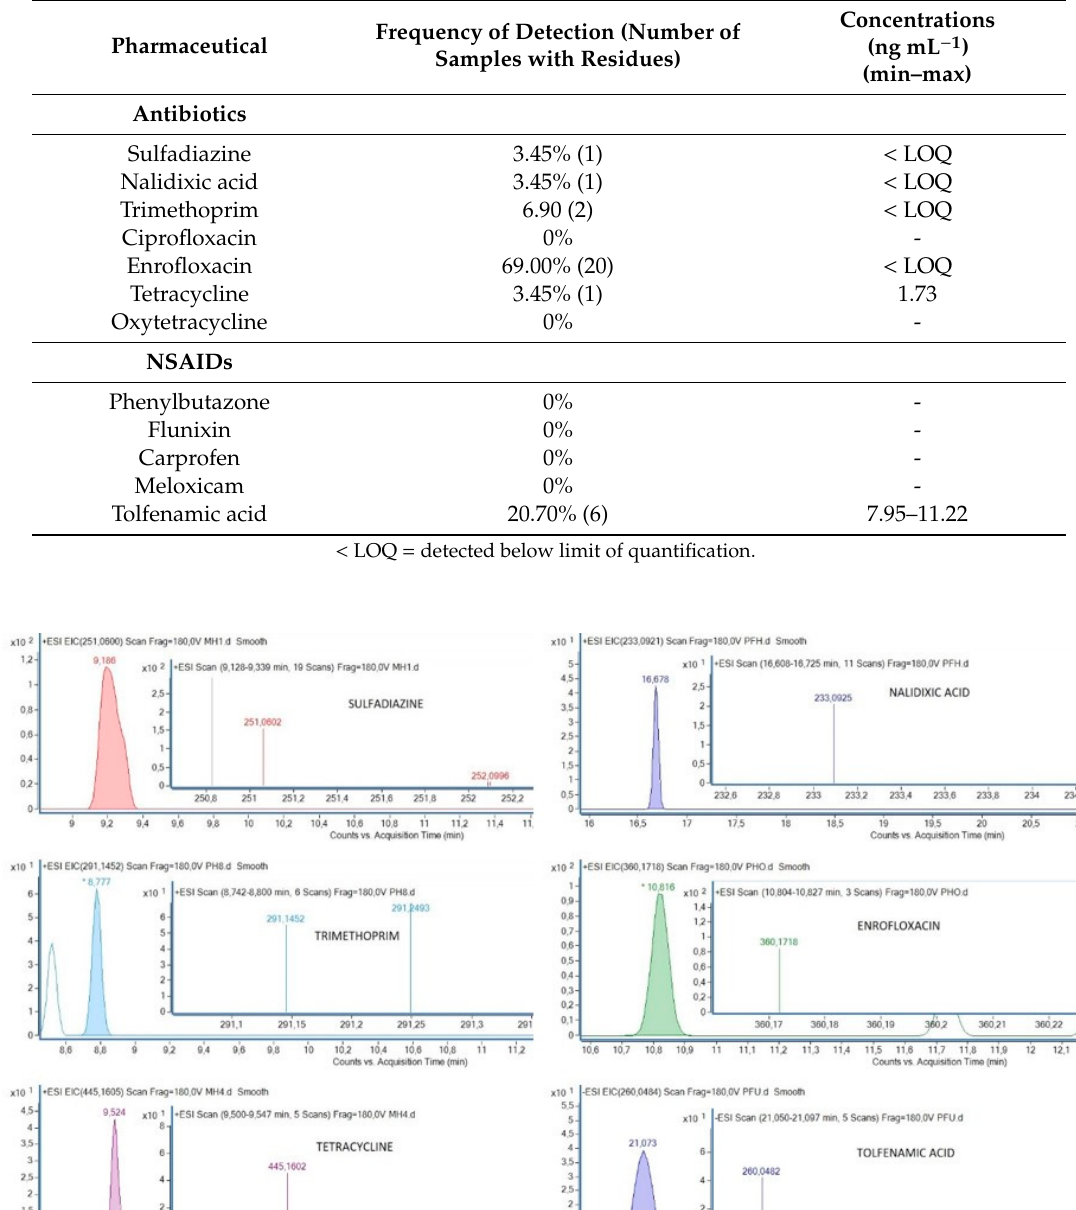
Table 4. Frequency of detection and concentrations of antibiotics and NSAIDs in plasma of 29 gri ff on vulture nestlings.